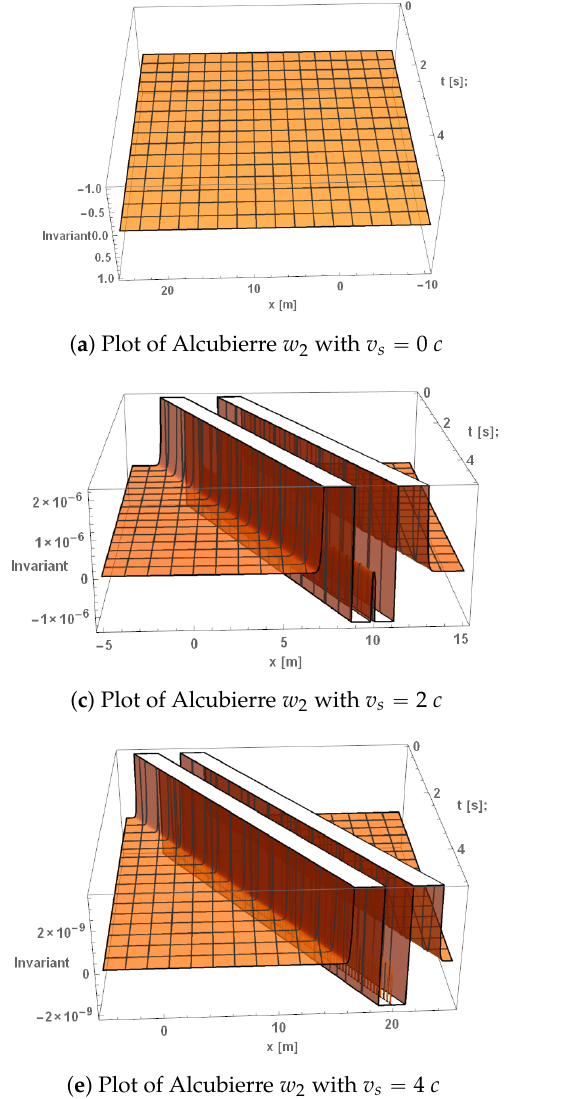
Figure A2. Plots of the w 2 invariants for the Alcubierre warp drive while varying velocity. The radius was chosen as ρ “ 1 m to match the parameters Alcubierre originally suggested in his paper [1]. The skin depth was chosen as σ = 2 m ´ 1 to keep the plots as machine size numbers. Equation (8) is in natural units, so the speed of light was normalized out of the equation. The factor of c was included in these captions to stress that the plots are of multiples of the speed of light. Their units are ms ´ 1